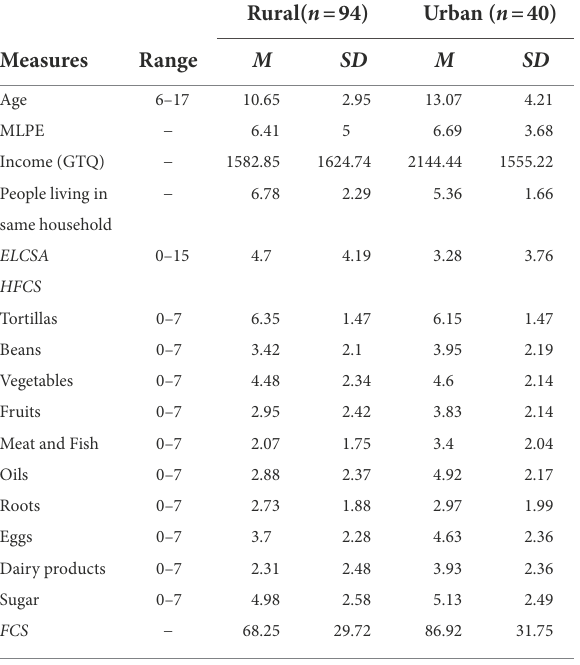
TABLE 1 Demographic and Food Consumption Patterns Broken Down by Rural/Urban